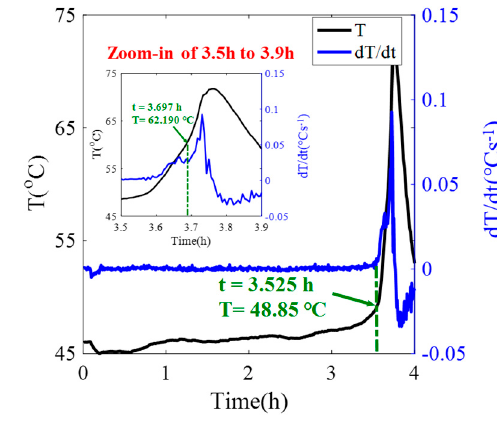
( f ) Figure 7. Overcharge test results for battery A1: ( a ) voltage and current profiles, ( b ) temperature profile, ( c ) photos of the battery (top view), ( d ) X-ray images of the battery (side view), ( e ) evolution of TOF, and ( f ) evolution of PA. The ultrasonic features during the overcharge test are shown in Figure 7e,f. Figure 7e shows that the TOF shifts towards the lower value before 2.5 h, which is in agreement with [26] (due to the change of SOC). The TOF begins to increase at about 2.8 h. One possible interpretation of this increase is that the TOF has already indicated a tiny amount of gas generated inside the battery. In addition, an increase of the thickness of battery layers may also increase the value of TOF. Then, the TOF